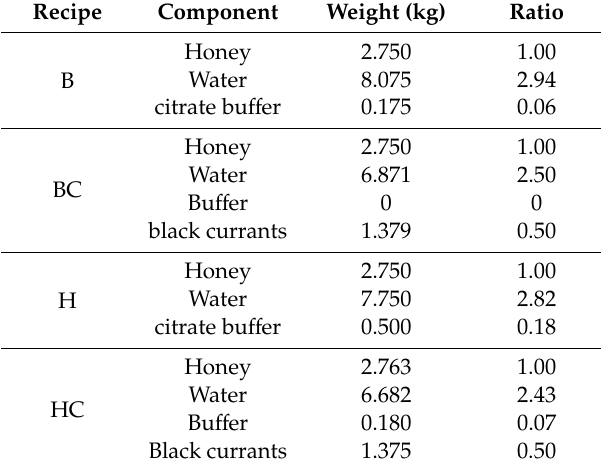
Table 2. Ingredients used for the four recipes tested for honey wine production. Weight is referring to the total amount of 11 kg prepared for each recipe before aliquoting the 3.5 L of each replicate (n = 3). B: blossom honey; BC: blossom honey with black currant; H: honeydew honey; HC: honeydew honey with black currant. Recipe